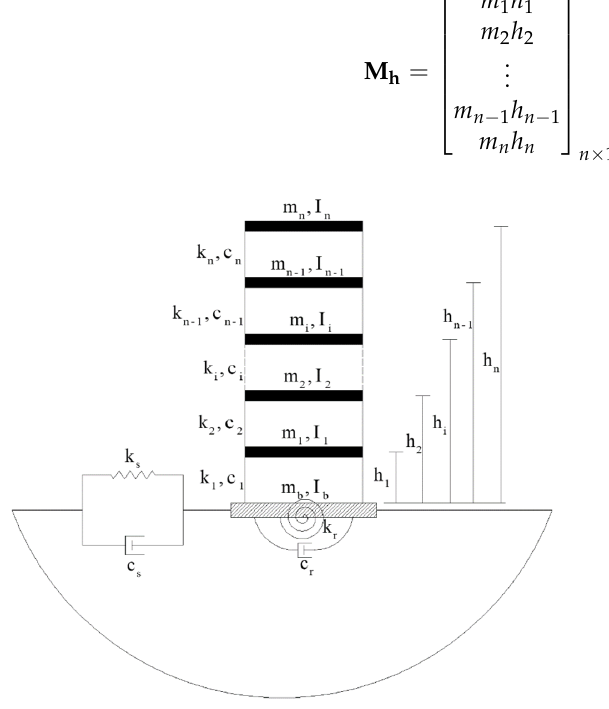
Figure 3. Shear building considering SSI.